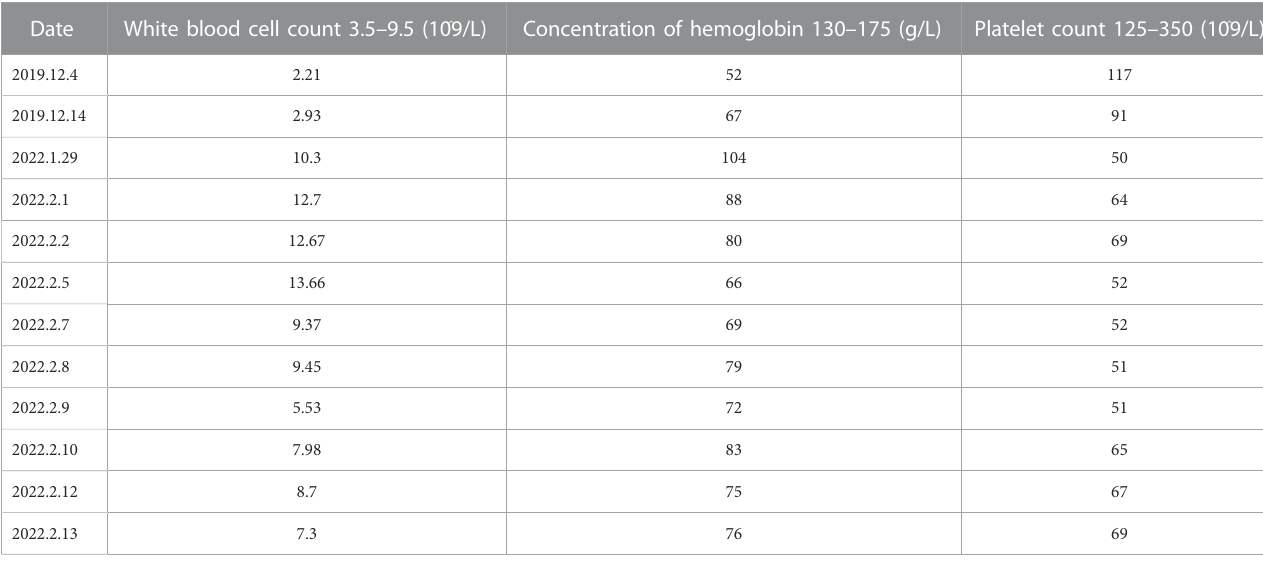
TABLE 1 Results of some blood routine examinations of patients.